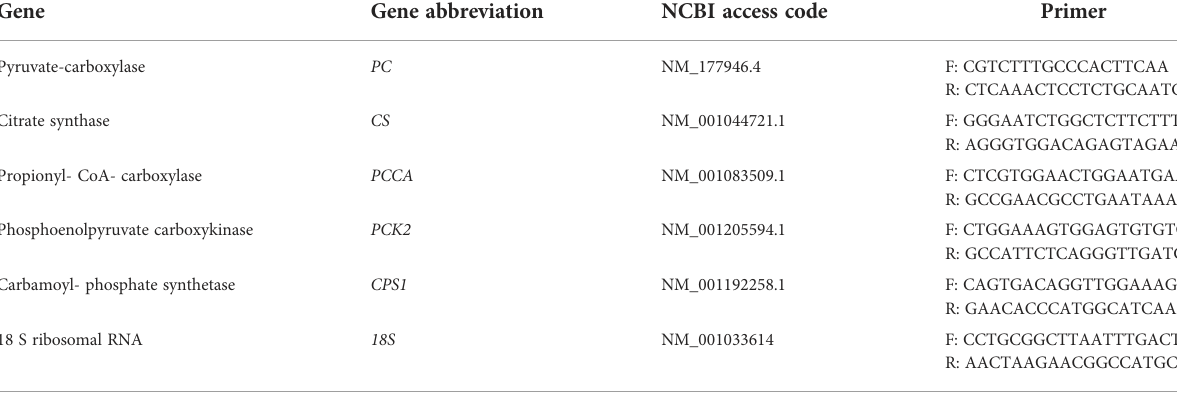
TABLE 2 List of primers for mRNA relative abundance analyses by